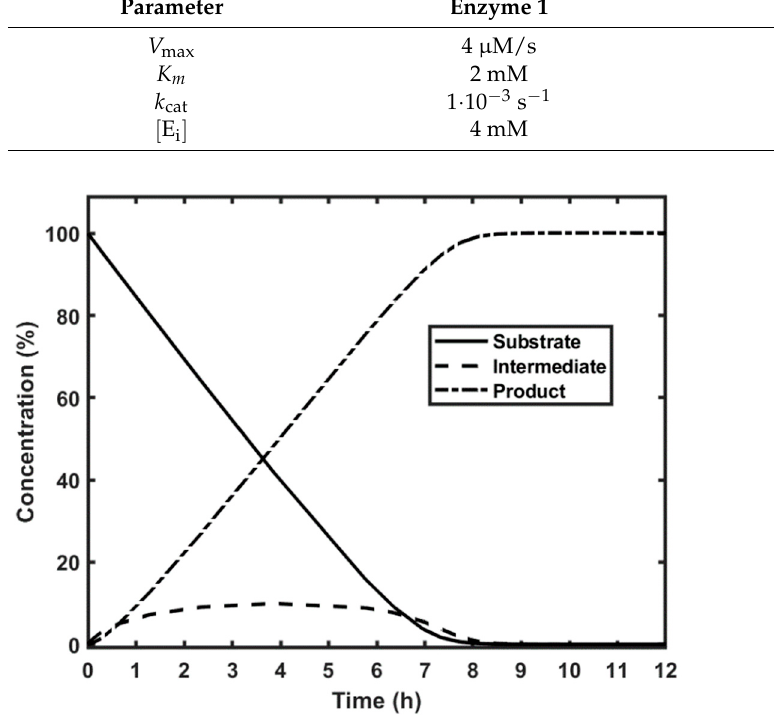
Figure 2. Reaction course in the first cycle of the cascade reaction catalyzed by E 1 and E 2 using the kinetic parameters and initial enzyme concentrations listed in Table 1.